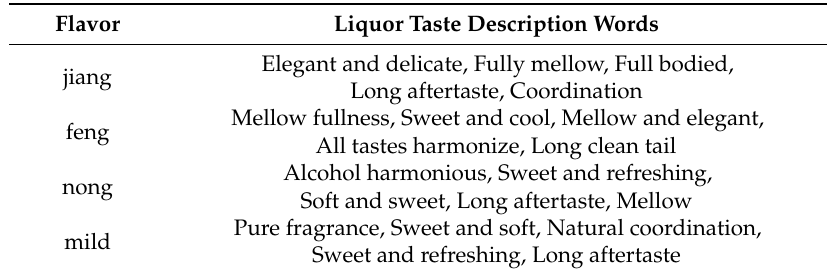
Table 2. Liquor taste description